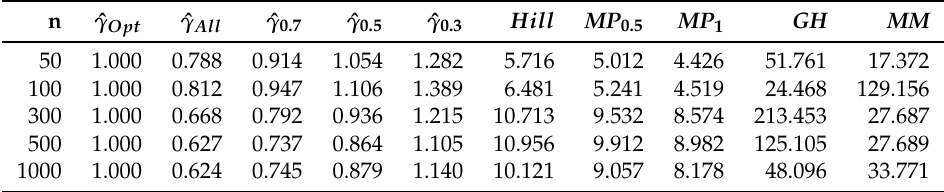
Table 2. Relative RMSE of the estimators for the Pareto(4) distribution; 1000 Montecarlo replications.